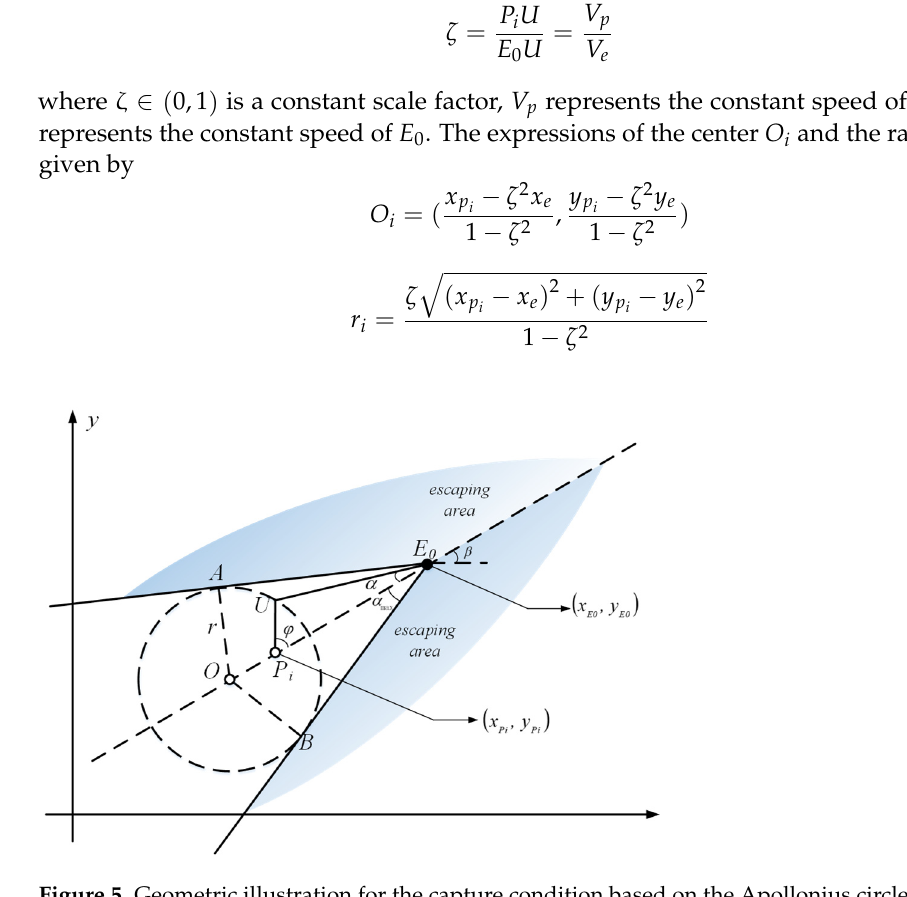
Figure 5. Geometric illustration for the capture condition based on the Apollonius circle.